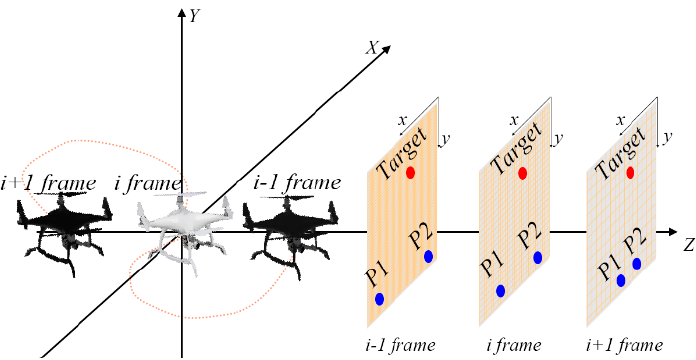
Figure 7. Schematic diagram of UAV out-of-plane motion.